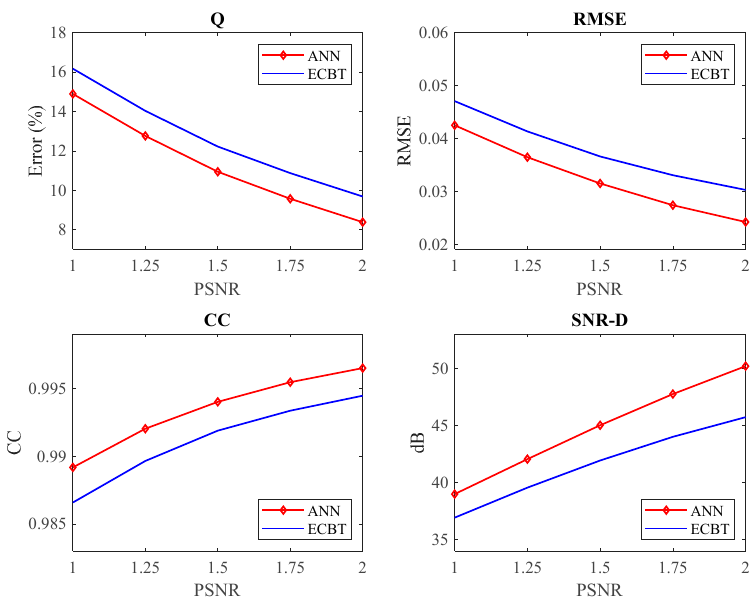
Figure 15. Results of denoising from RF signal in di ff erent noise levels where PSNR ranges from 1 to